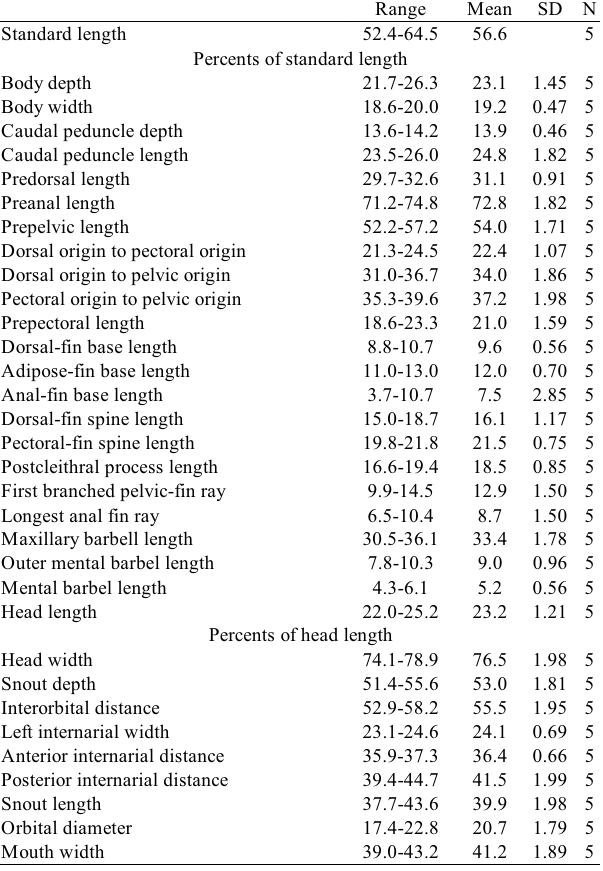
Table 3. Morphometric data for Tatia boemia . SD = standard deviation.